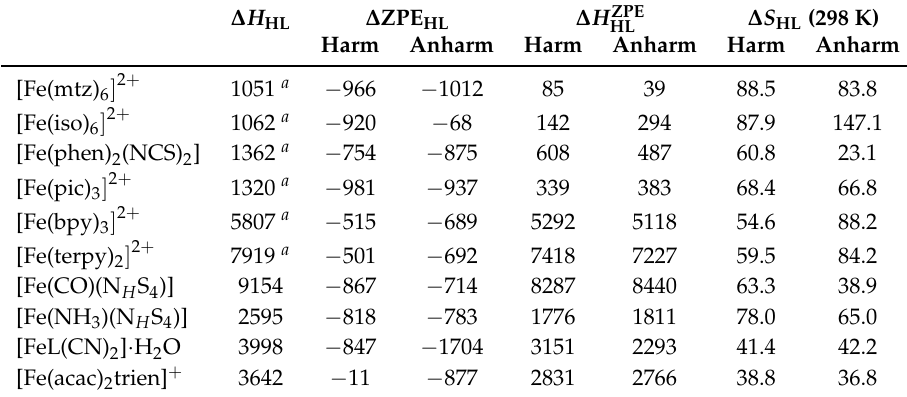
Table 2. TPSShvalues of the HS-LS energy difference, ∆ H HL , zero point energy (ZPE)